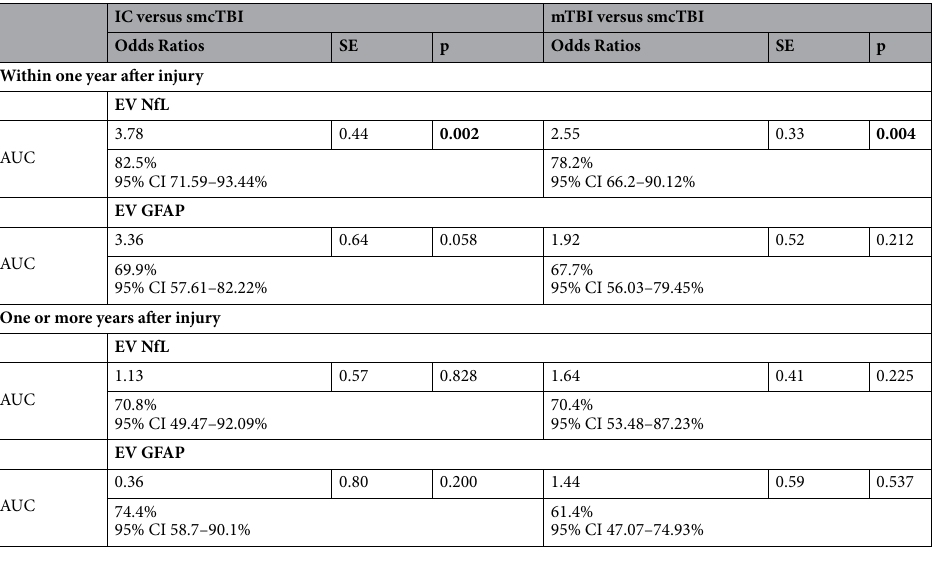
Table 2. Logistic regression analysis comparing groups within one year and one or more years after injury. Logistic regression analysis was performed to compare biomarker differences among. Logistic regression models included demographics (age, gender, race) and time since injury when comparing a TBI group and the injured control group. When comparing two TBI groups, number of TBIS was also included in the model. Biomarker concentrations were natural log transformed. P values for significant predictors are marked in bold. Odds ratio, Standard errors (SE) and p values for NfL and GFAP in each model are shown. Area under the Receiver Operating Characteristic Curves (AUCs) for each model are also provided. IC, injured controls; mTBI, uncomplicated mild TBI; smcTBI, complicated mTBI, moderate TBI, and severe TBI combined; TBI, traumatic brain injury; TSI, time since injury (orthopedic injury or TBI); NfL, Neurofilament light chain; GFAP, glial fibrillary acidic